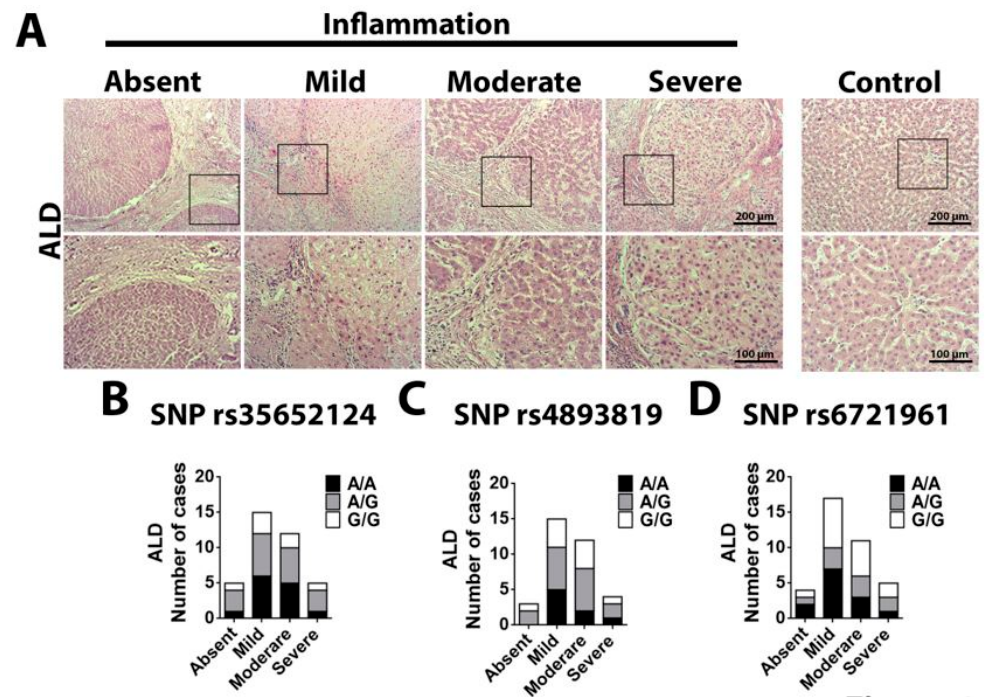
Figure 3. Inflammation score in the different polymorphism of NFE2L2 gene in patients with cirrhosis